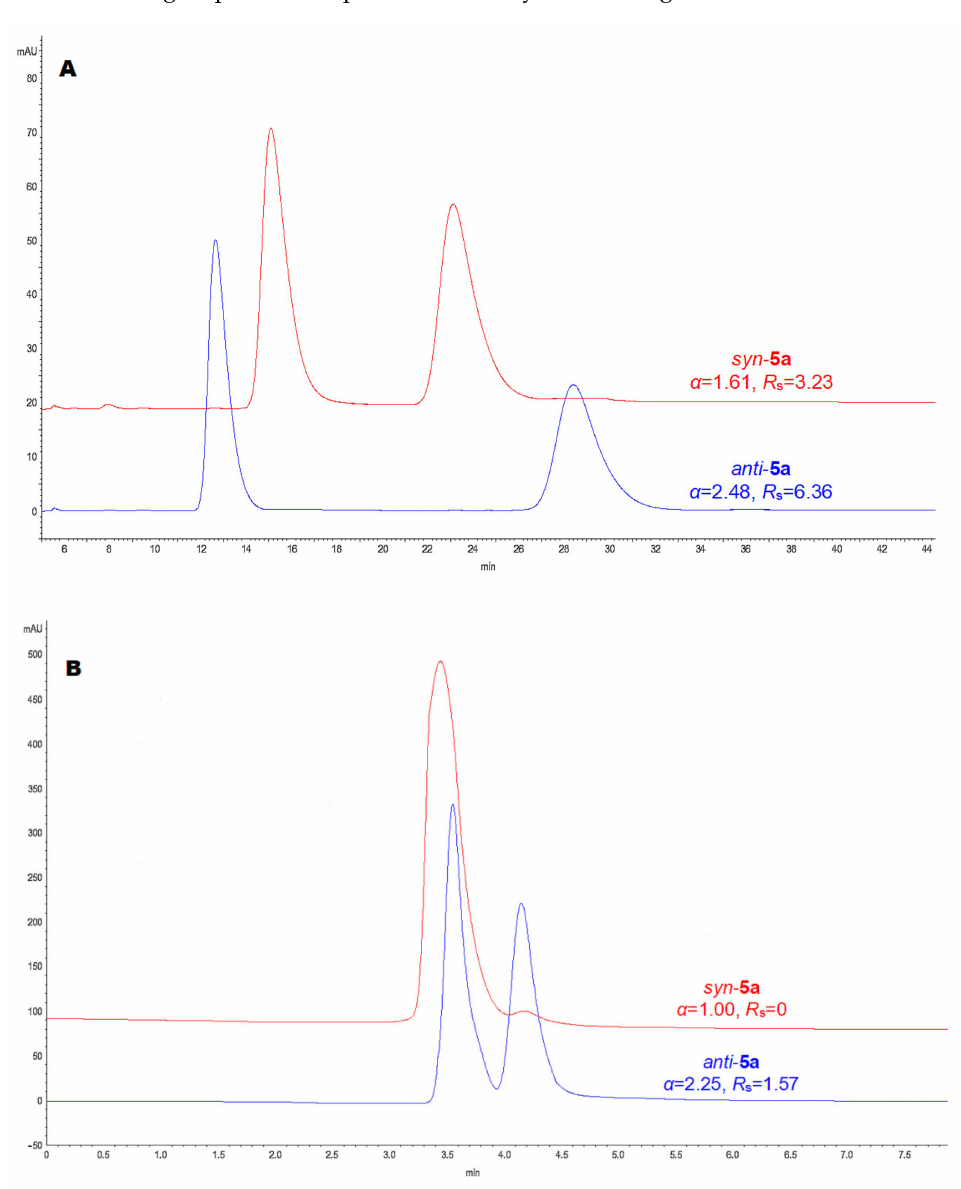
Figure 5. HPLC overlay chromatograms of ( ± )- syn - 5a and ( ± )- anti - 5a on Amylose-SA column with: ( A ) n -hexane/2-PrOH (90/10, v / v ) and ( B ) 100% DMC as mobile